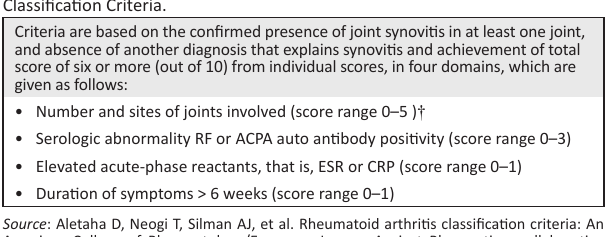
BOX 1: Diagnostic criteria for rheumatoid arthritis: 2010 American College of Rheumatology/European League Against Rheumatism Rheumatoid Arthritis